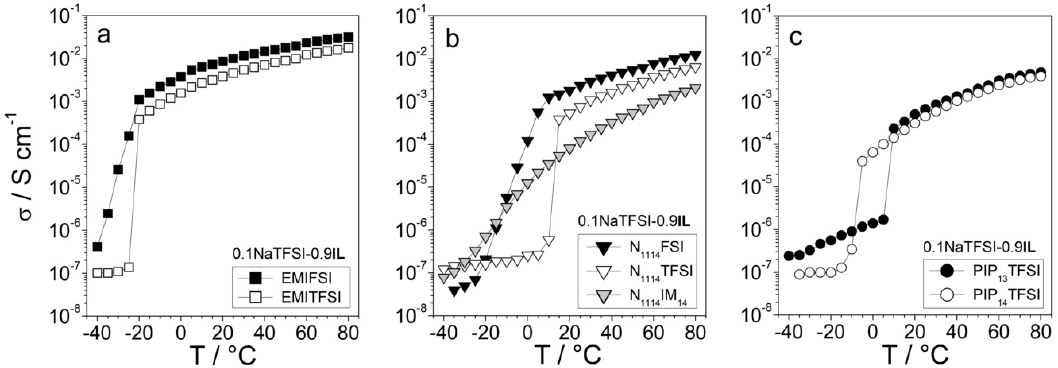
Figure 1. Ionic conductivity vs. temperature dependence of 0.1NaTFSI-0.9IL sodium electrolytes: ( a ) EMI-based electrolytes; ( b ) N 1114 -based electrolytes; ( c ) PIP 1A -based electrolytes.